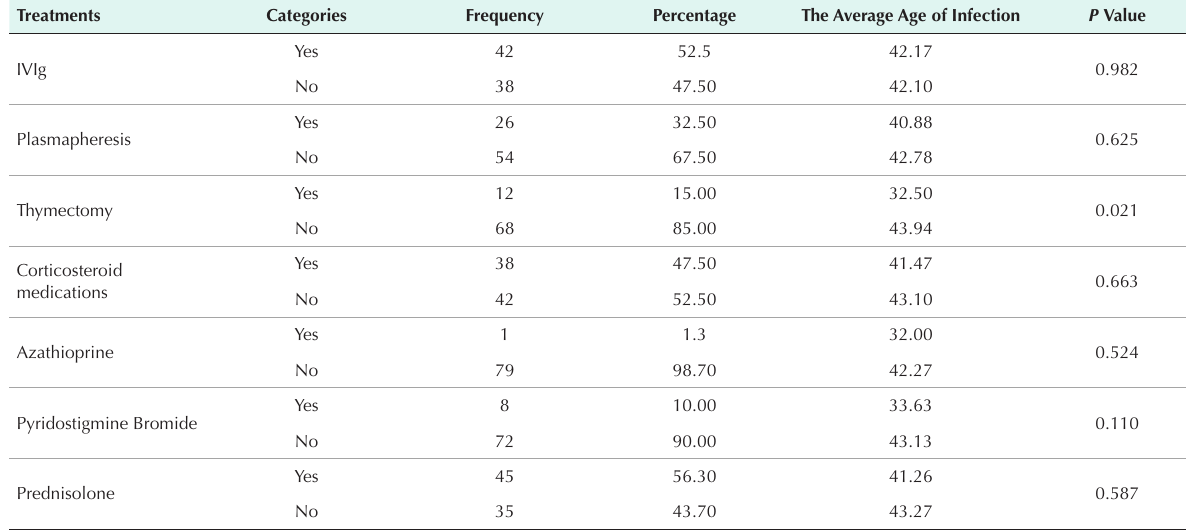
Table 4. The Average Age of the Infection of Patients Based on Medications and Treatments